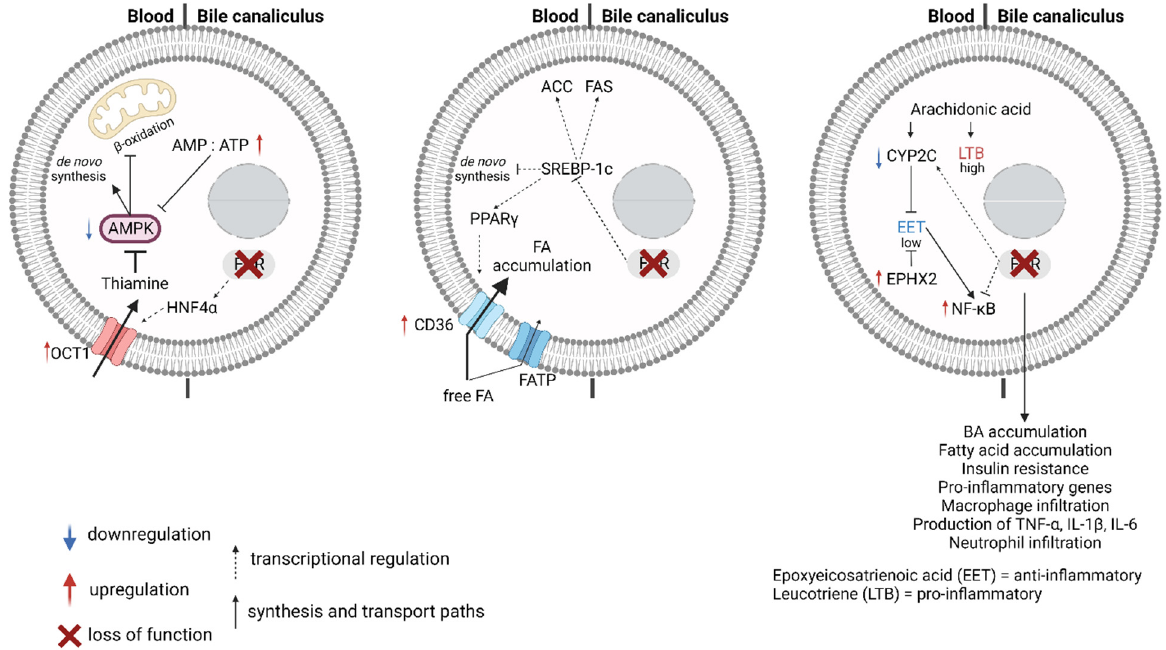
Figure 2. The role of FXR in hepatic lipid accumulation and toxicity. First panel : Alterations in thiamine uptake and AMPK activation correlate with NAFLD and liver disease. Second panel : Dysregulation of lipid metabolism causing a toxic intrahepatic accumulation of fatty acids leads to NAFLD and correlates to a low expression of FXR. The cellular influx of triglycerides increases and the conversion to fatty acids is enhanced. Third panel : In hepatocytes, FXR maintains the equilibrium between epoxyeicosatrienoic acid and leukotriene. ACC = Acetyl-CoA carboxylase, ACOX1 = 2-trans-enoyl-CoAs by the acyl-CoA oxidase 1, AMP = Adenosine monophosphate, AMPK = AMP-activated protein kinase, ATP = Adenosine triphosphate, CD36 = Fatty acid translocase, CPT1 = Carnitine palmitoyltransferase-1, FA = Fatty acid, EPHX2 = Epoxide hydrolase 2, FABP = Fatty acid binding protein, FAS = Fatty acid synthetase, FATP = Fatty acid transport protein, FXR = Farnesoid X receptor, HNF4 α = Hepatocyte nuclear factor 4 alpha, NAFLD = Non-alcoholic fatty acid liver disease, OCT1 = organic cation transporter 1, PPAR γ = Peroxisome proliferator-activated receptor gamma, SREBP-1c = Sterol regulatory element-binding protein 1c; Figure has been created with